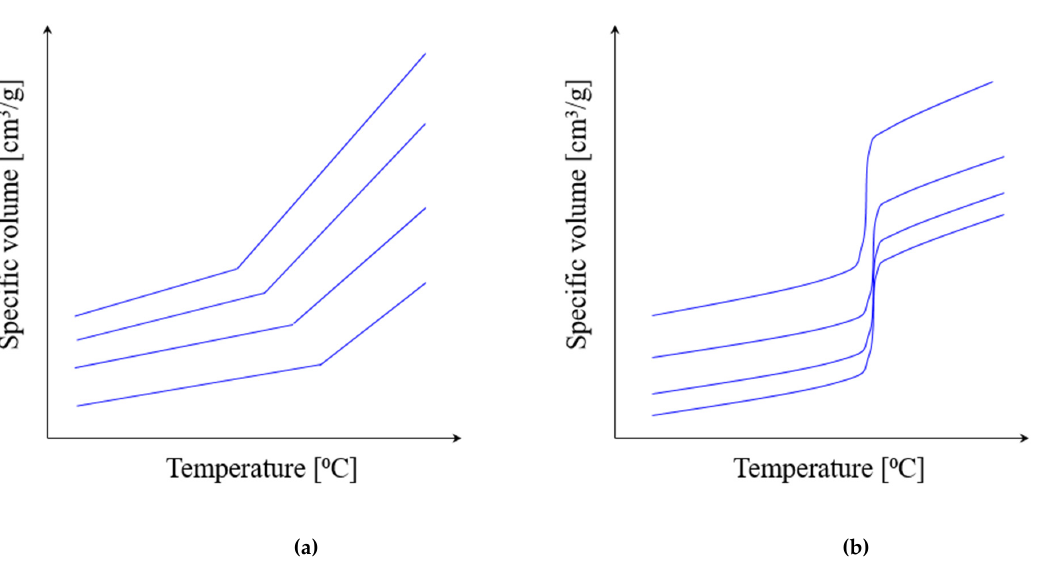
Figure 10. The typical pvT diagrams for thermoplastic polymers (schematically): ( a ) amorphous thermoplastics; ( b ) semi-crystalline thermoplastics; ( b ) semi ‐ crystalline thermoplastics.